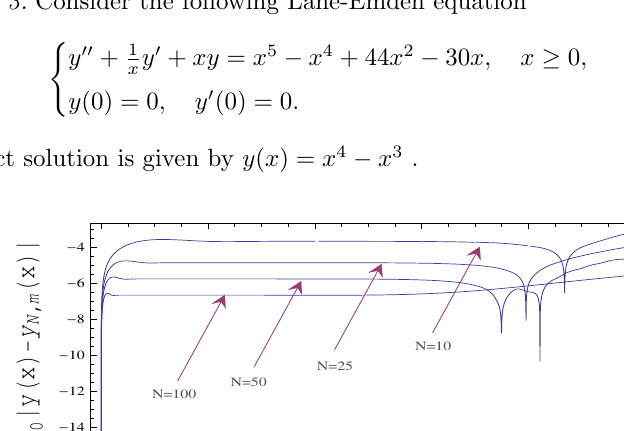
Figure 6 shows the absolute errors (in logarithmic scale) of approximations with m = 10 iterations and N = 10 , 25 , 50 , 100.